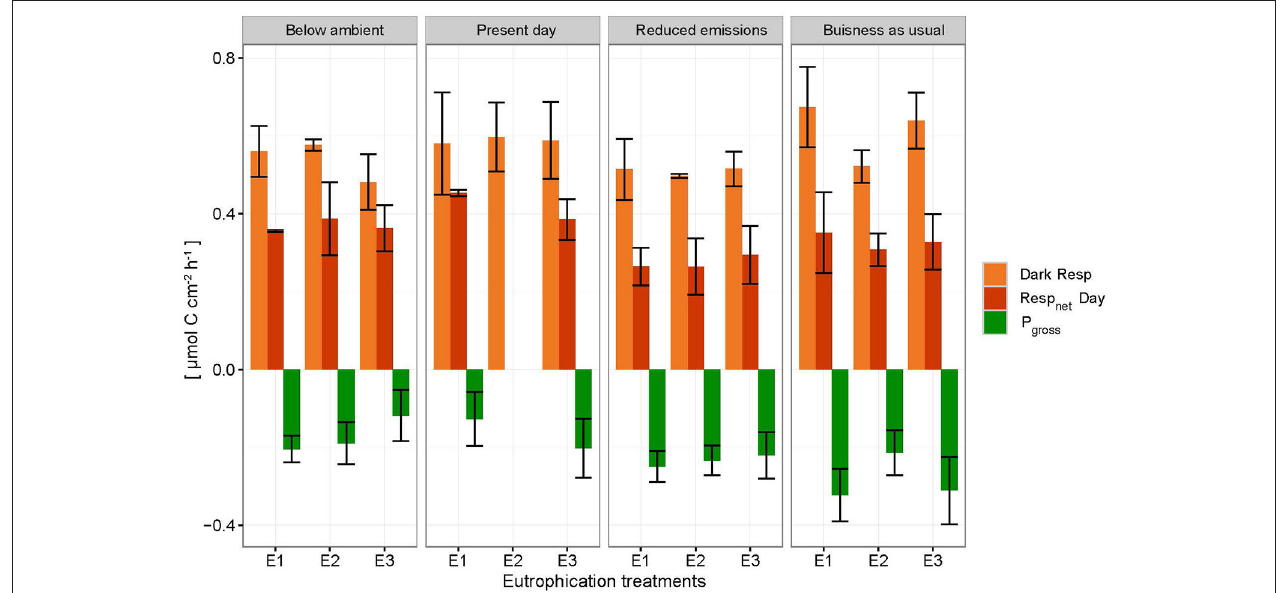
FIGURE 6 | Net respiration rates (Resp net ) during the day (dark orange), dark respiration rates (dark Resp) during the night (light orange) and gross photosynthesis (P gross ) of the holobiont (sponge + symbionts) ± SEM for each p CO 2 and eutrophication scenario. P gross was derived from the net respiration of the symbionts (shown as negative respiration in the figure by assuming that 1 mole CO 2 respired during the night equals 1 mole O 2 produced during the